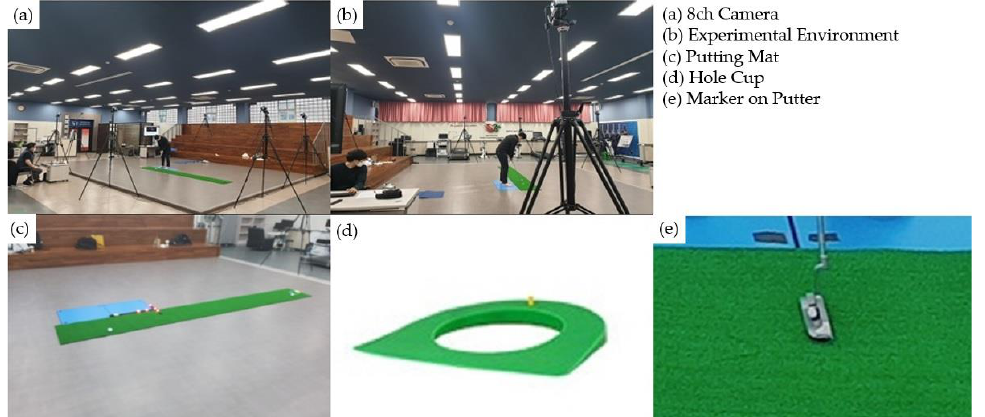
Figure 1. Experimental environment.